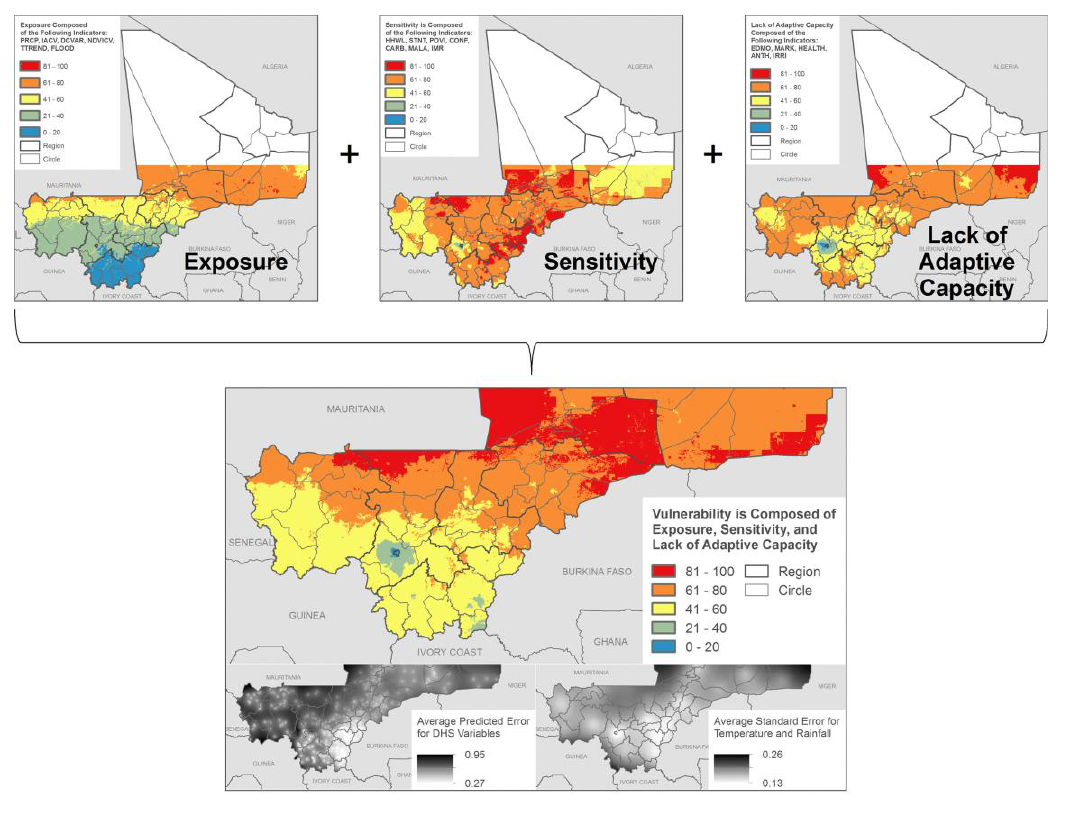
Figure 10. Mali vulnerability mapping: Components of vulnerability rolled up into an overall vulnerability index. Note: Northern portions of Mali were excluded owing to low population